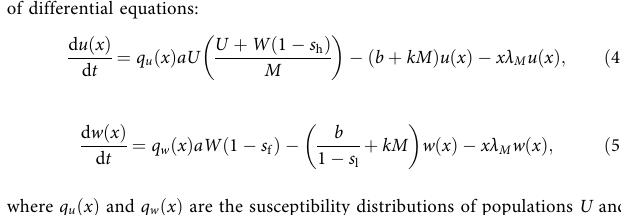
estimates (Table 1), which are interpreted and used in the dynamic models of Wolbachia invasion and dengue transmission.